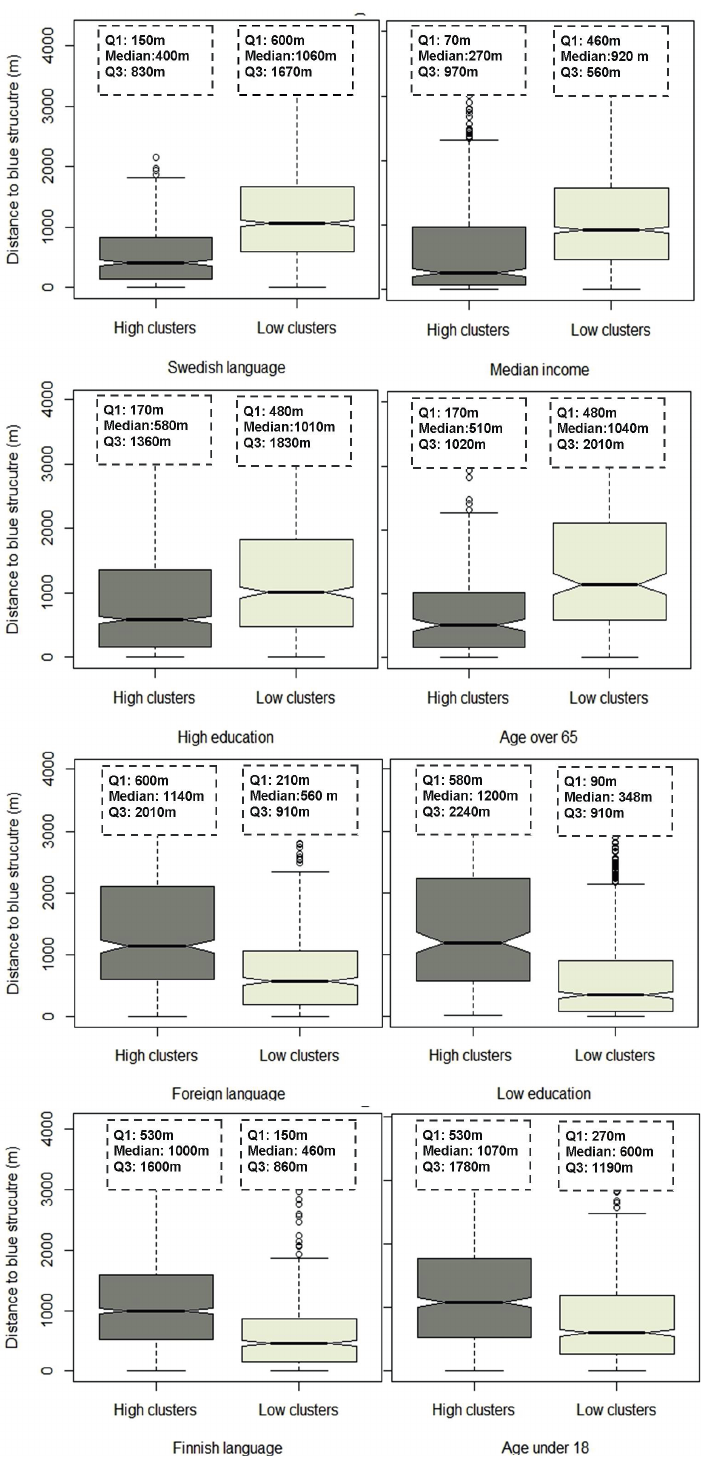
Fig. 4. Cluster distances to water areas in the studied socio- economic and demographic population groups in the Helsinki Metropolitan Area